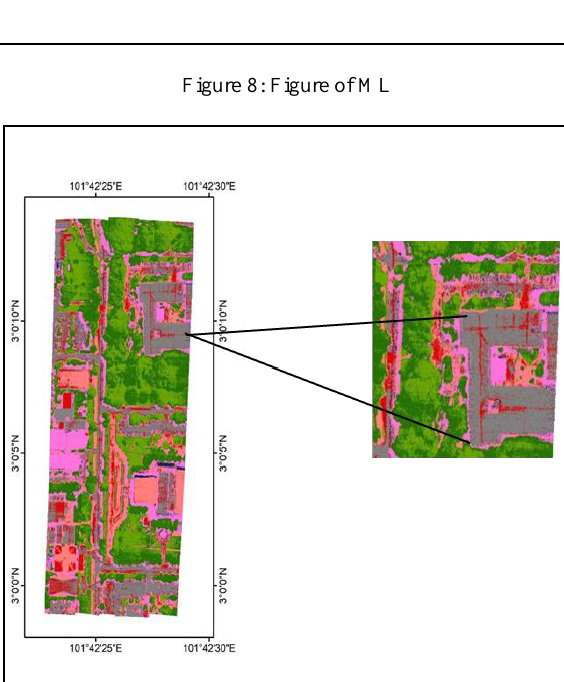
Figure 9: Figure of